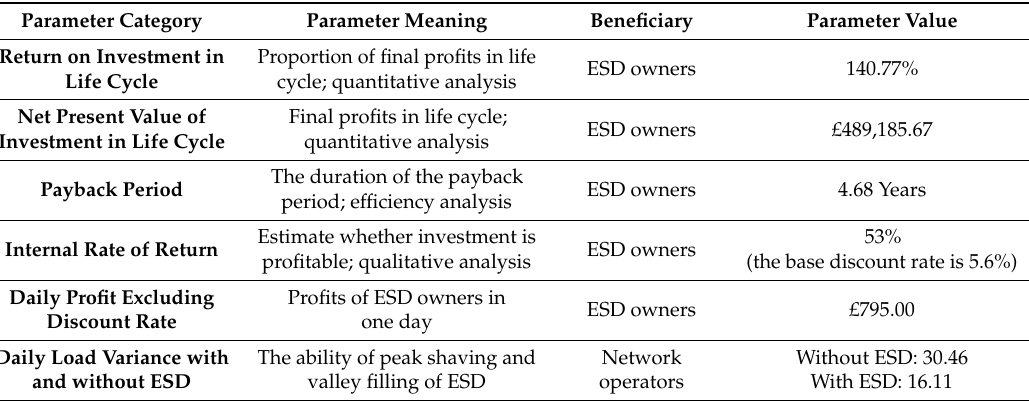
Table 2. Annual cost present value after power